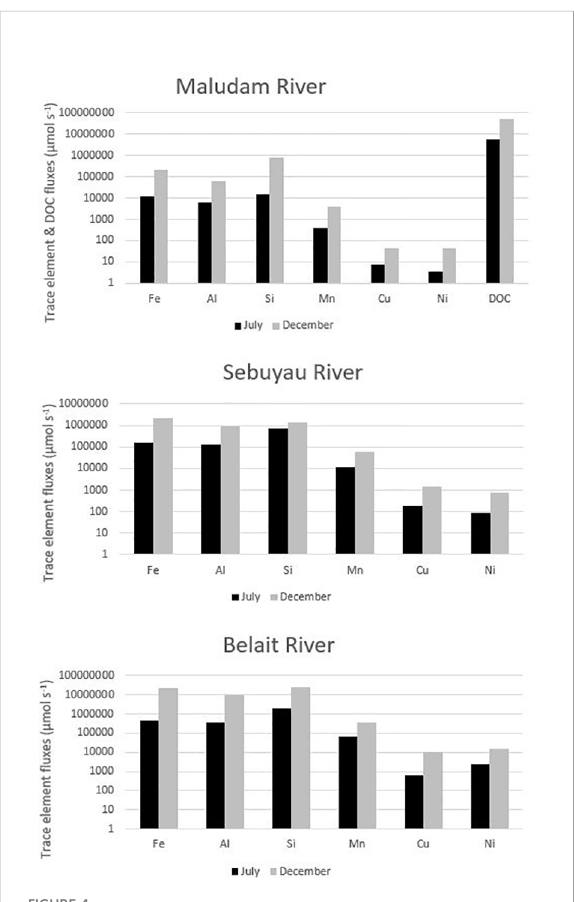
FIGURE 4 Trace element and DOC fl uxes (µmol s − 1 ) as a function of seasonal variation in the freshwater endmember of Maludam, Sebuyau and Belait rivers. Key: July (Dry Season) and December (Wet